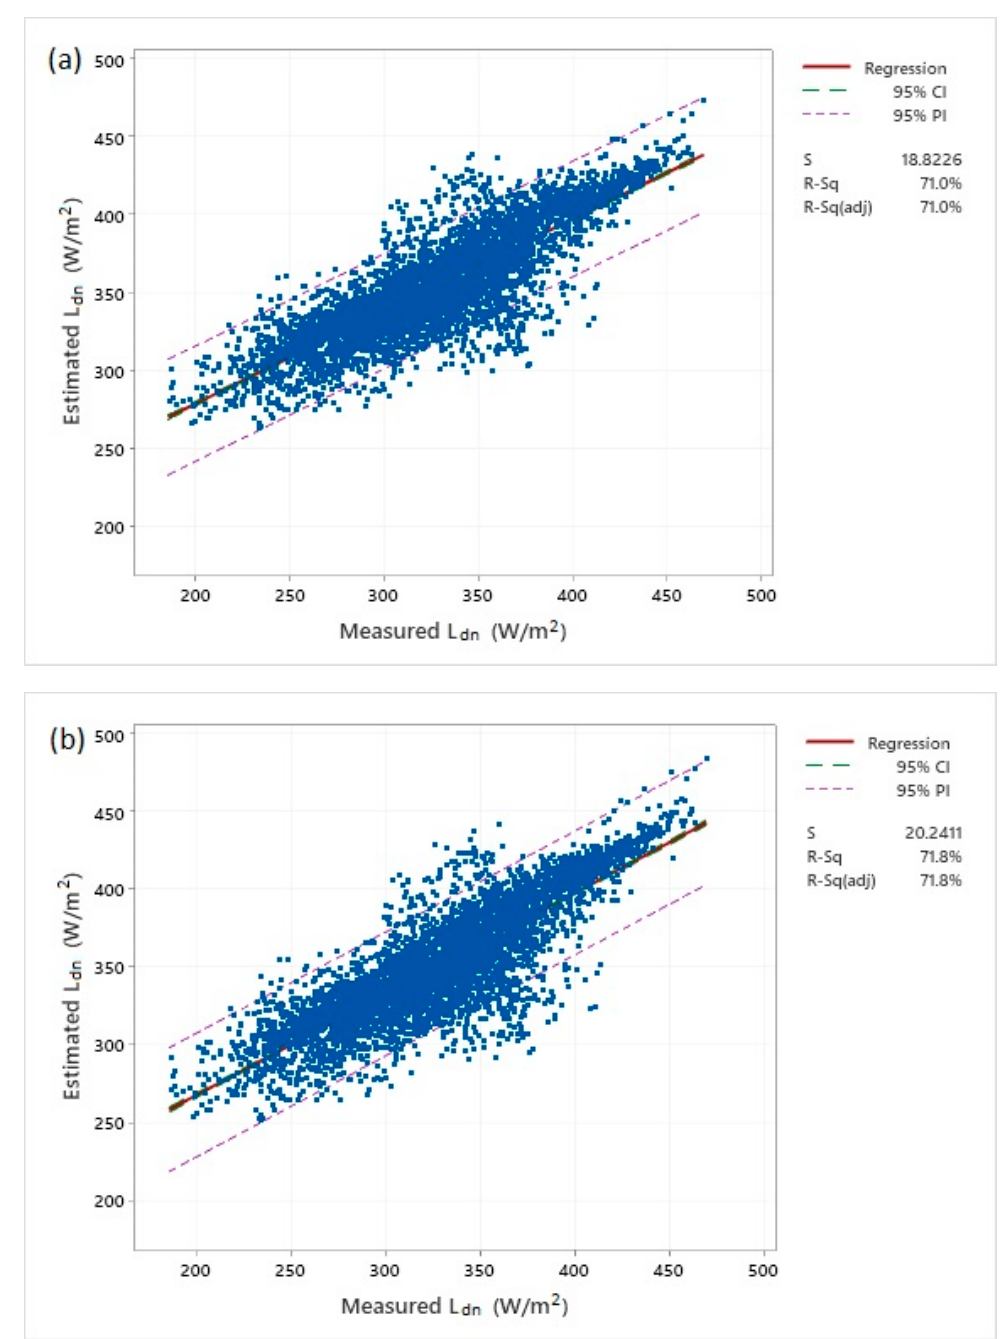
Figure 16. Comparison of measured and estimated hourly daylight downward longwave irradiances under all-sky conditions for the calibrated coefficients of ( a ) Idso’s and ( b ) Brunt’s models at Athalassa using the current dataset (2016–2017).